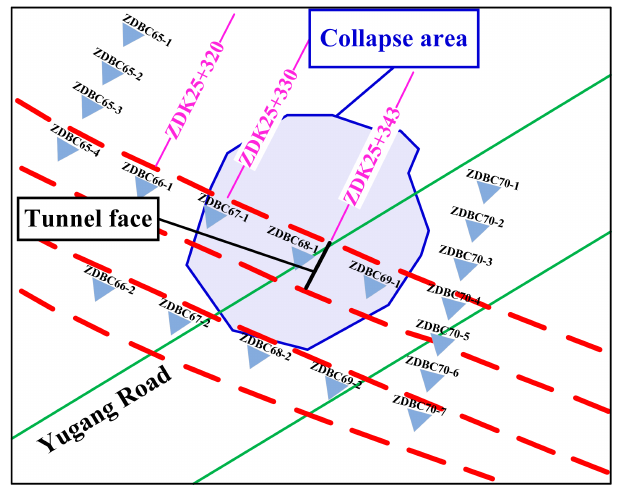
Figure 12. Distribution of monitoring